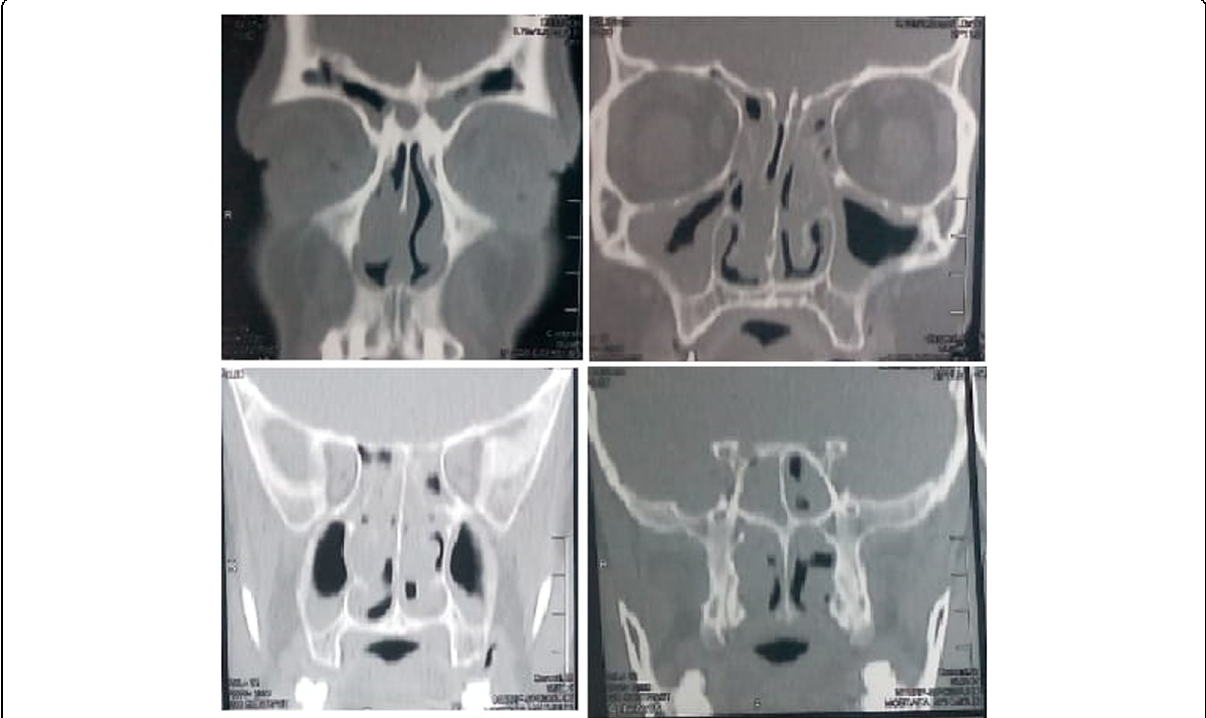
Fig. 7 CT PNS of case from the oral group, before treatment